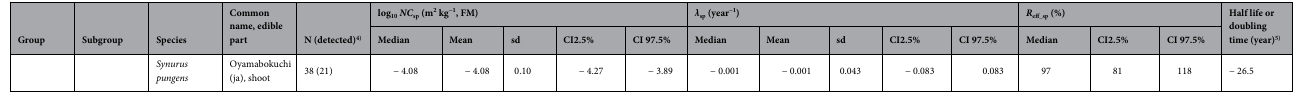
We obtained posterior results of each parameter by Bayesian estimation. Using these parameters, we estimated the 137 Cs concentration of each specimen based on models and compared it with the measured value (Fig. 2). In Fig. 2a, the estimated median from the sub-village model was plotted, and results of whole village model were shown in Fig. 2b. For additional comparison, the plots were separately shown for mycorrhizal mushrooms, sap- rotrophic mushrooms, and wild plants. Among mushroom species, mycorrhizal fungi form symbiotic relation- ships with plants and uptake carbon via plant roots, while saprotrophic fungi decompose dead or dying organic matter for their nutrition. In both models, the estimated and measured values were distributed around the 1:1 line. The deviation from the 1:1 line was slightly smaller in the sub-village model. Among detected samples (blue symbols), 71% (1926/2700) and 67% (1801/2700) of the estimated values from the sub-village model and the whole village model were within ten times the range of the measured values (yellow belts in Fig. 2), respectively. The difference was significantly different ( p < 0.001, chi-squared test, Table S3). Table 2 shows the posterior distributions of individual error ( σ ) and the hierarchical parameters. The sigma ( σ ), which indicates the magnitude of the deviation from the mean estimated by the model ( μ sample ), was 0.51 for the sub-village model and 0.57 for the whole village model. The 95% confidence intervals for σ did not overlap between the two models (0.50–0.53 in the sub-village model and 0.55–0.59 in the whole village model); this indicates that the variability of the concentration becomes smaller when the sampling points can be specified at the sub-village level. The variability parameters of the concentration characteristics among species ( σ sp ) were 0.81 and 0.83, which were larger than the individual error.